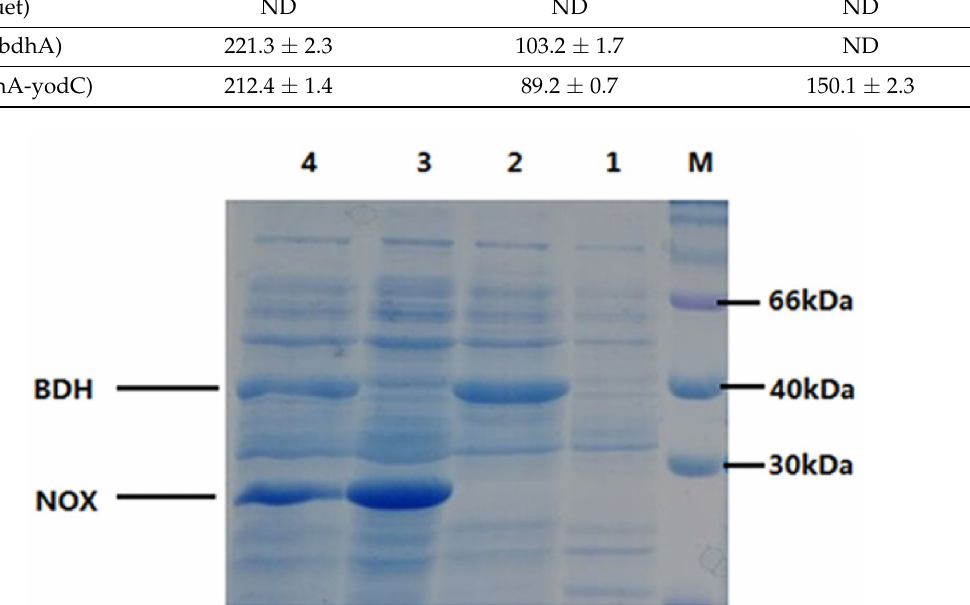
Table 3. Enzyme activity and the whole-cell biocatalytic activity of different strains. Strains